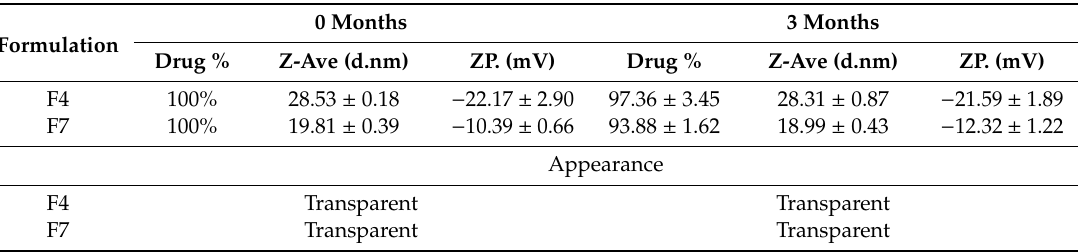
Table 3. Time-dependent stability studies showing the droplet size (upon dispersion) and drug recovery after three months at room temperature. CUR dissolved in the formulations is equivalent to 80% of equilibrium solubility.